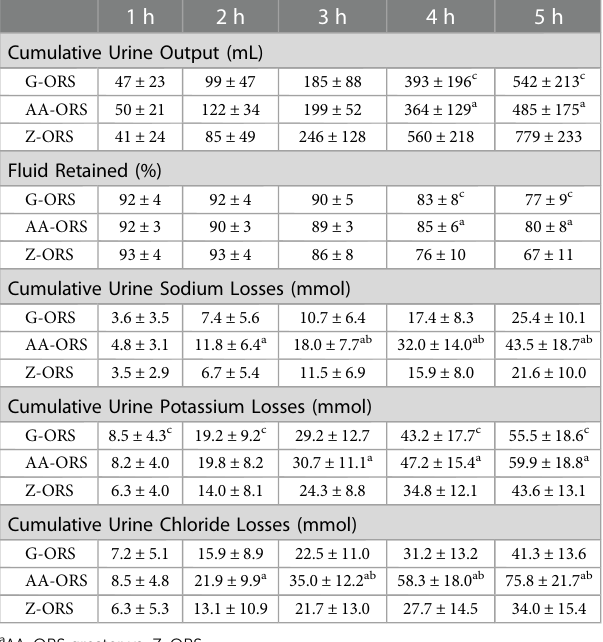
TABLE 4 Cumulative urine output, fl uid retention and urine electrolyte losses.